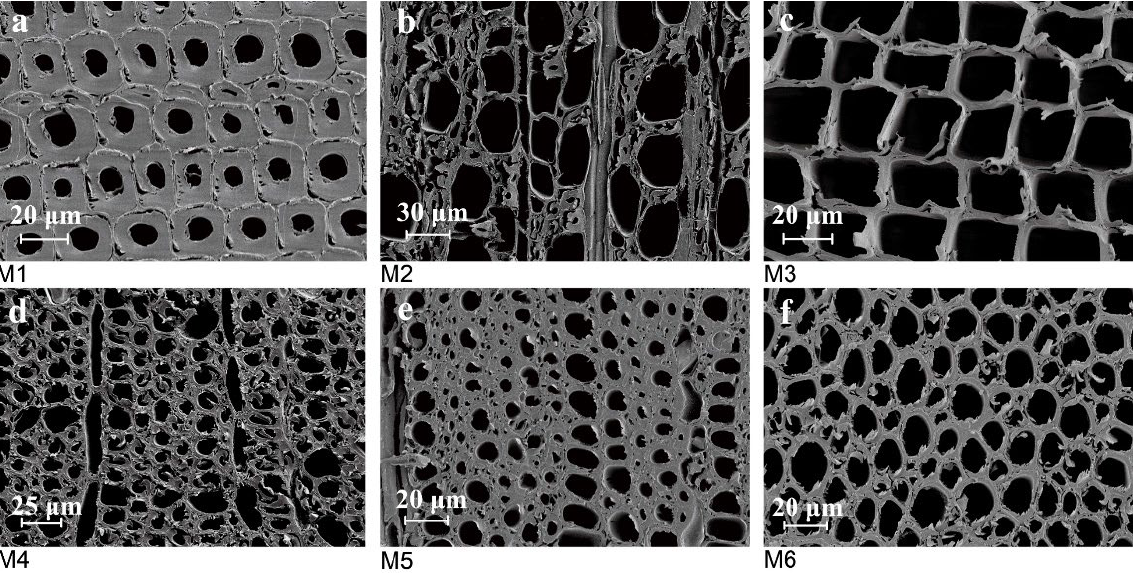
Figure 3. Scanning electron micrographs of modern wood (( a ), mason pine; ( b ), sweet gum; ( c ), fir; ( d ), persimmon; ( e ), banyan; ( f ), teak).